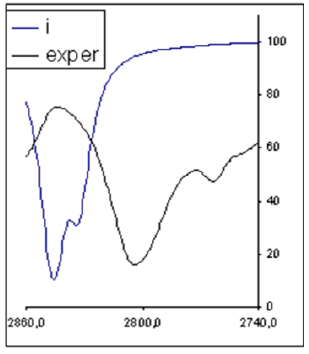
Figure 5. Experimental and calculated Bolhmann bands for ETABOC (C i conformer).